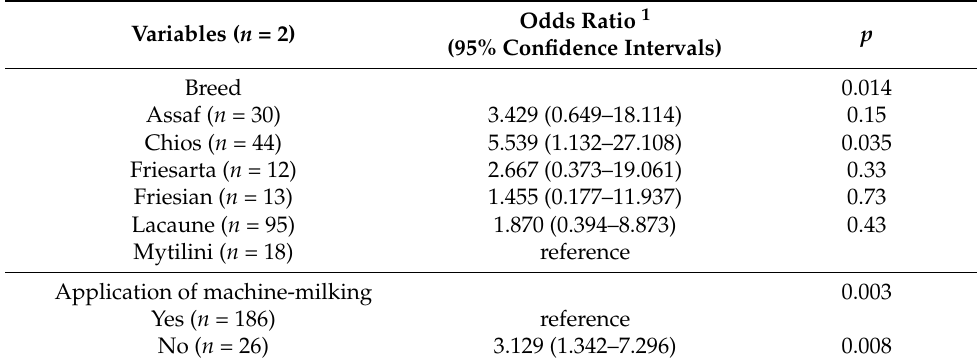
Figure 3. Proportion of flocks with increased somatic cell counts (>0.75 × 10 6 cells mL − 1 ) in the bulk-tank milk of sheep flocks in Greece in accordance with the breed of sheep therein. Table 3. Results of multivariable analysis for increased somatic cell counts (>0.75 × 10 6 cells mL − 1 ) in the bulk-tank milk of sheep flocks in Greece (mixed effects logistic regression and analysis with only flocks with the six most frequently recorded breeds).